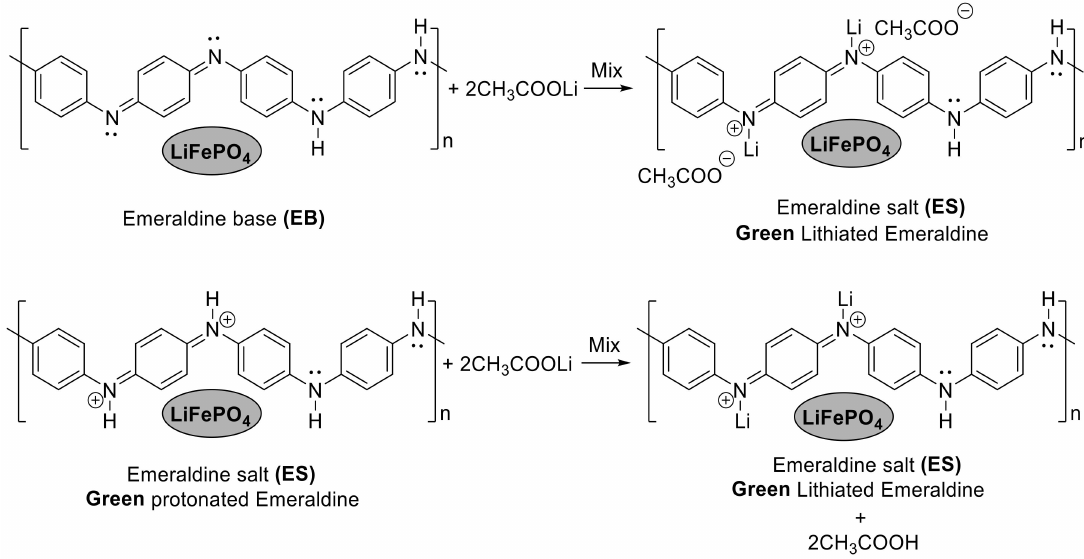
Figure 3. Reactions of ES (emeraldine salt) and EB (emeraldine base) with